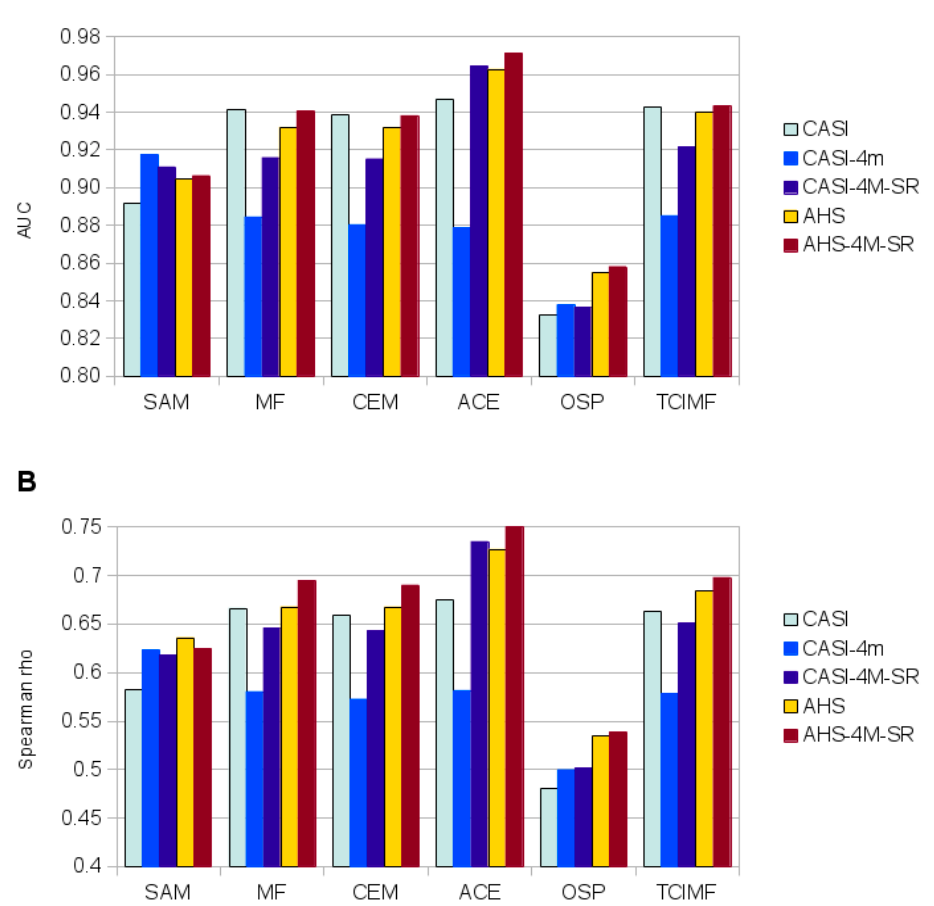
Figure 8. Evaluation of detection algorithms. SAM = Spectral Angle Mapper, MF = Matched Filter, CEM = Constrained Energy Minimization, ACE = Adaptive Coherence Estimator, OSP = Orthogonal Subspace Projection, TCIMF = Target-Constrained Interference-Minimized Filter. Hyperspectral images: CASI-4m, CASI-4M-SR, CASI, AHS-4M-SR and AHS. Evaluation at the new site “Codo de la Esparraguera”, ( A ) AUC of a ROC plot for S. densiflora presence/absence at sampling points (n = 43 vs. 68). ( B ) Spearman Rho correlation between rule-image value and S. densiflora ground-cover class, n = 129 sample points.